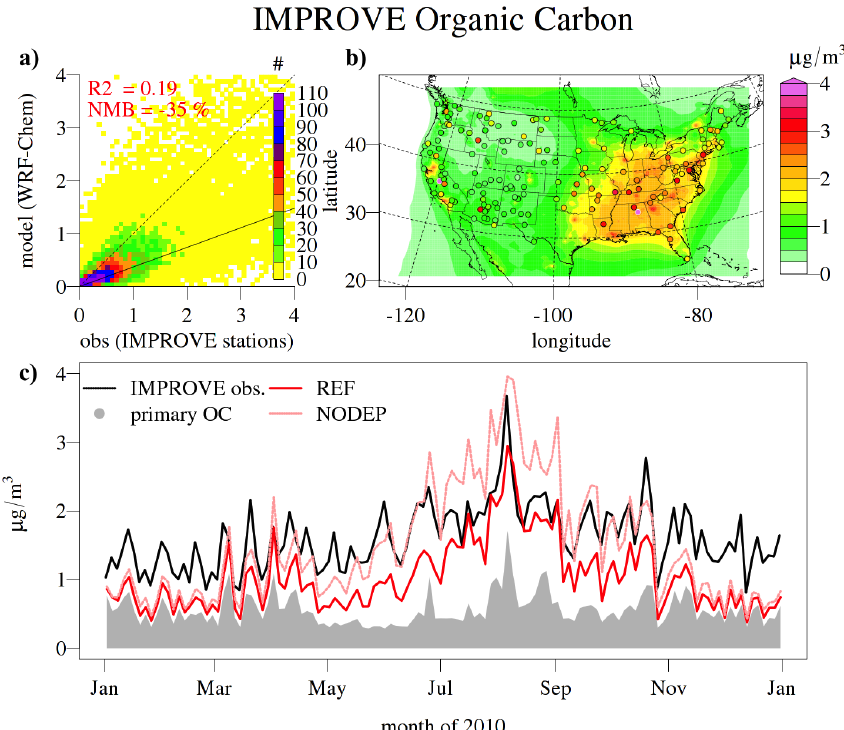
Figure 5. Evaluation of ground level total organic carbon (OC) concentrations against IMPROVE measurements. (a) density scatterplot of daily average concentrations at each IMPROVE station against modeled concentrations ( R 2 and NMB as defined in Fig. 3, again using the REF simulation). (b) annual average OC surface level concentrations (REF simulation). Filled circles represent measured concentrations. (c) time evolution of OC concentrations as average over all IMPROVE stations. Black solid line is measurement average. Grey area represents the POC (primary organic carbon) contribution to total OC (from REF simulation). Light red and red lines are NODEP and REF simulation averages of total OC